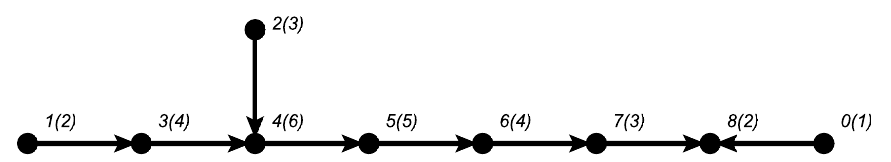
Figure 4. Oriented b E 8 quiver. The numbers in the parentheses represent the Coxeter labels d i